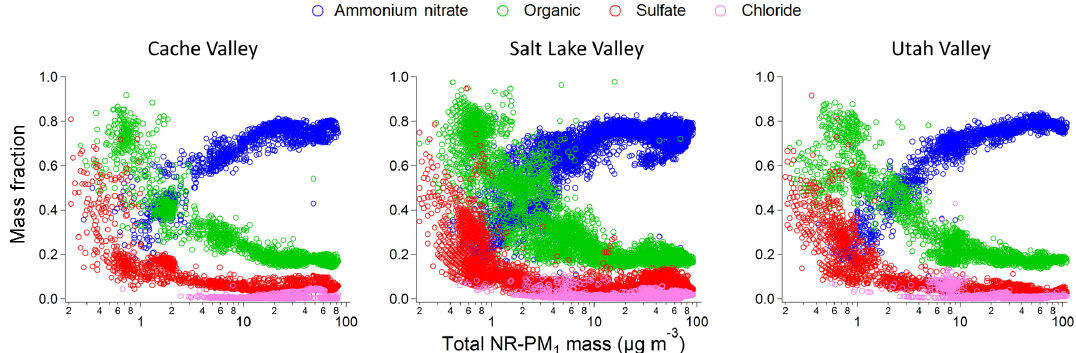
Figure 4. Aerosol mass fraction as a function of total NR-PM 1 mass for each of the three main study areas measured from the Twin Otter. Color code same as Fig. 3.